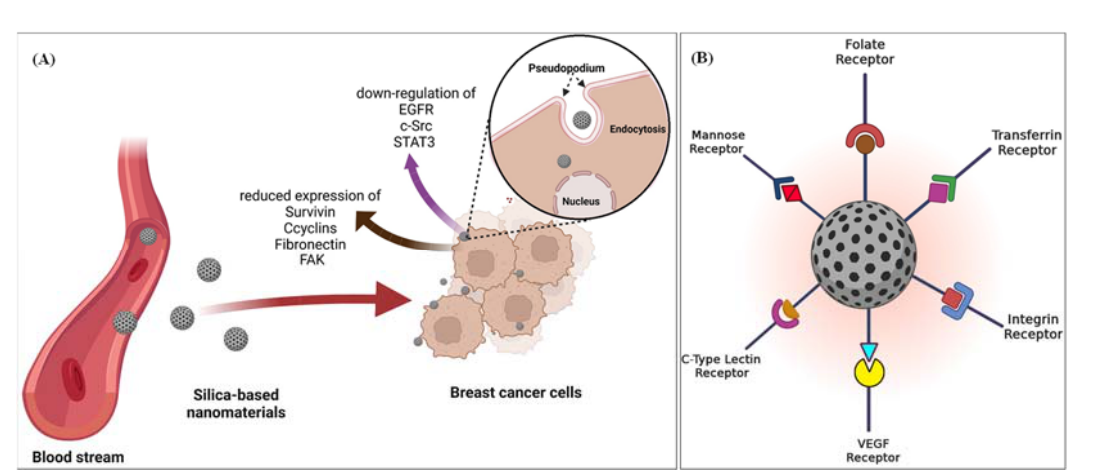
Figure 8. ( A ) Schematic model to illustrate endocytic mechanisms and the proposed mechanisms of SiNPs in breast cancer, based on recent studies [160,161] . ( B ) Probable surface modifications of MSNs to the overexpressed receptors in the cancer microenvironment.